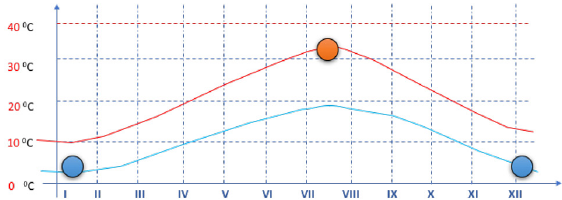
Fig. 3. Average monthly outdoor temperatures (max.– min.) for Ulcinj, (IHMS Montenegro 2015).